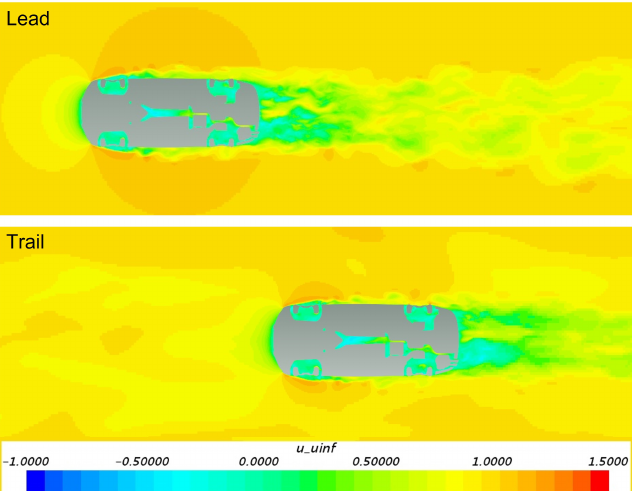
Figure 18. The normalized velocity along the z = 0.15 m plane on the leading and trailing